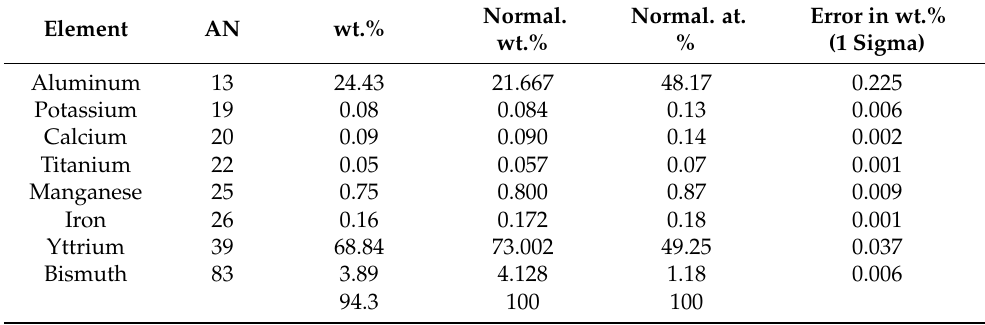
Table 1. Composition of YAB:Mn determined by X-ray fluorescence analysis. AN—atomic number. Element AN wt.%